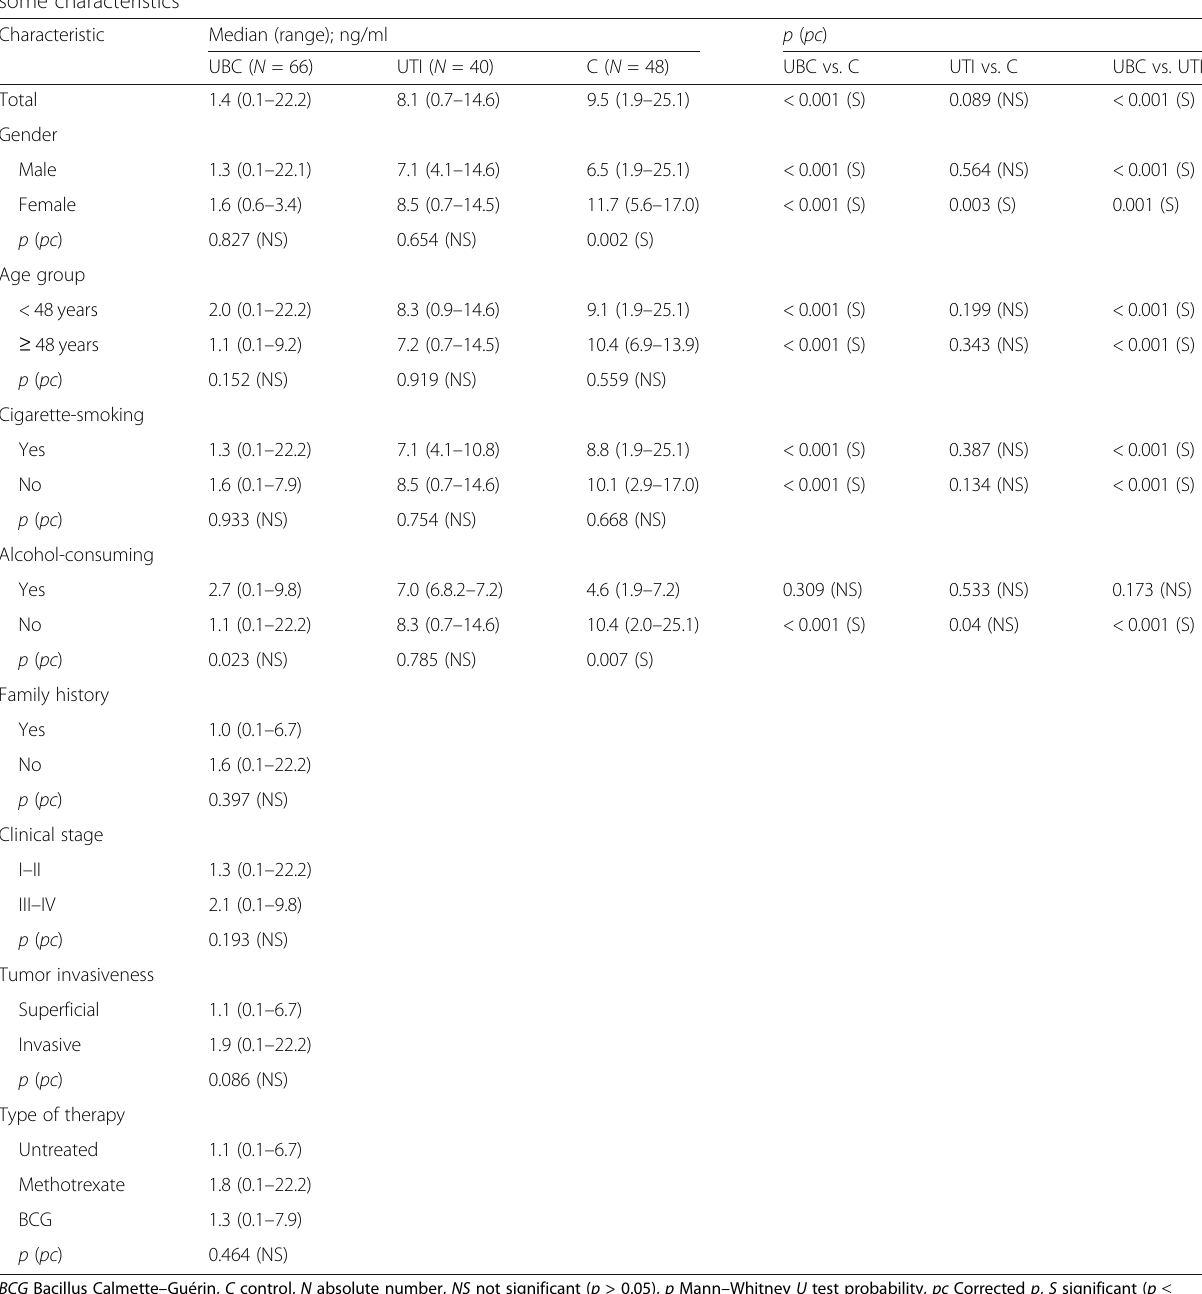
Table 2 Serum level of TLR-7 in urinary bladder cancer and urinary tract infection patients and control distributed according to some characteristics